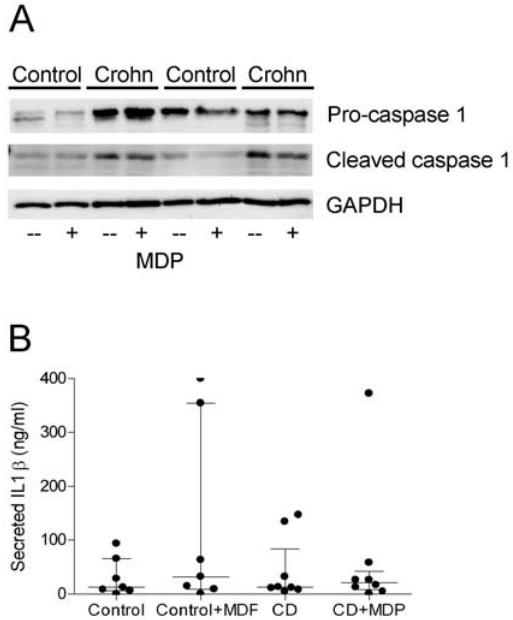
Figure 4. Caspase 1 processing and IL-1 b release. Immunoblot- ting of caspase 1 (A). CD patients had increased basal expression of pro- caspase 1 and active cleaved caspase 1. No response was seen to MDP stimulation. ELISA measurement of released active IL-1 b (B). Media was taken from monocytes stimulated for 24 hours with MDP. No differences in IL-1 b secretion were detected.